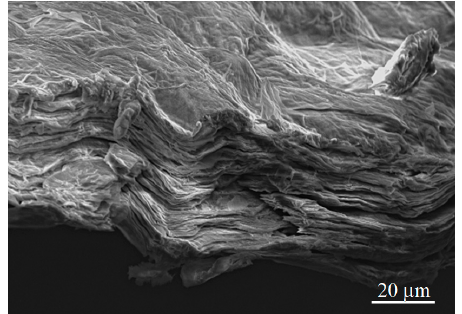
Figure 2. Multilayer structure of graphene paper (3500 × ).